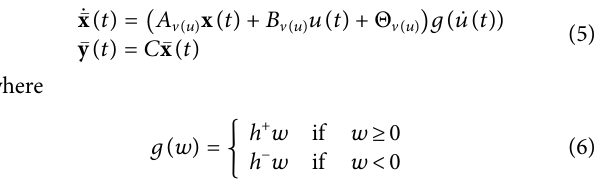
Frontiers in Robotics and AI |